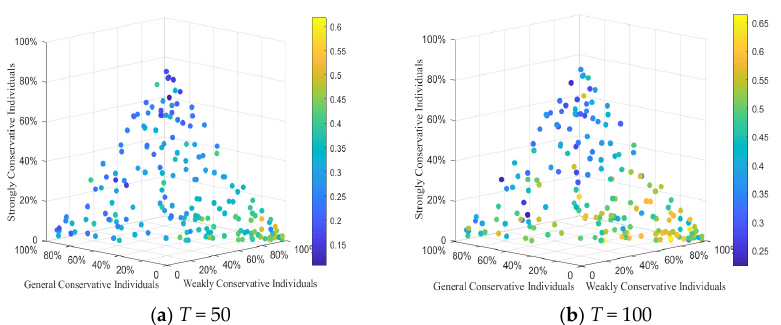
Figure 18. Attitude polarization of three conservative individuals at random proportion. ( a ) T = 50; ( b ) T = 100.